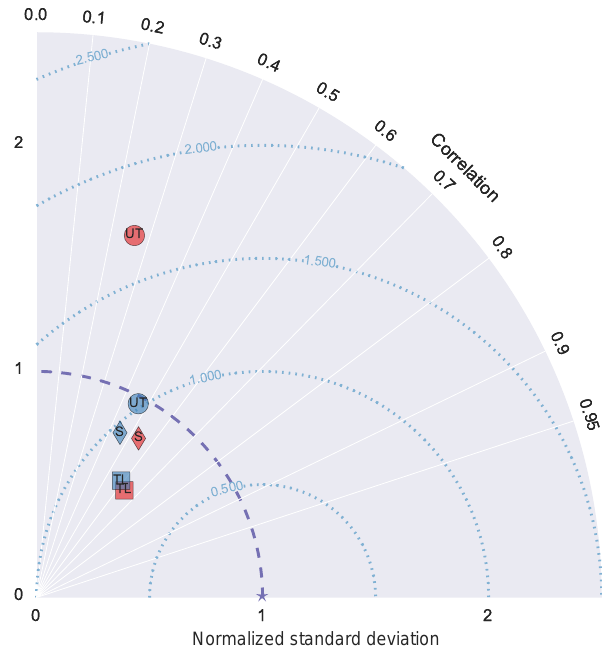
Figure 9. As in Fig. 5, but for water vapour. The UT in this case is defined as 178–316hPa, rather than 178–261hPa.